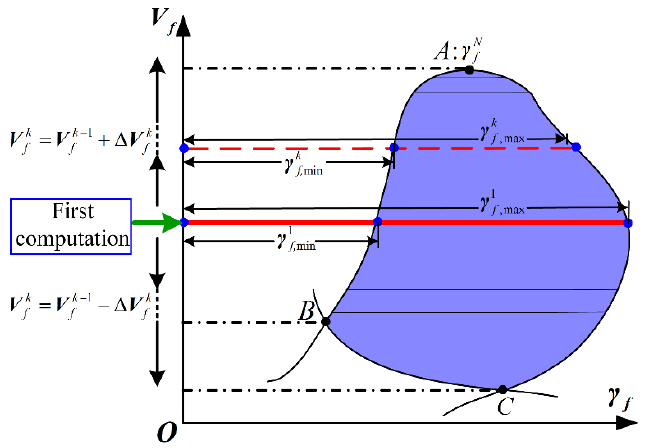
Figure 4. Solving the boundary of aerocapture attainability set by dimensionality reduction.